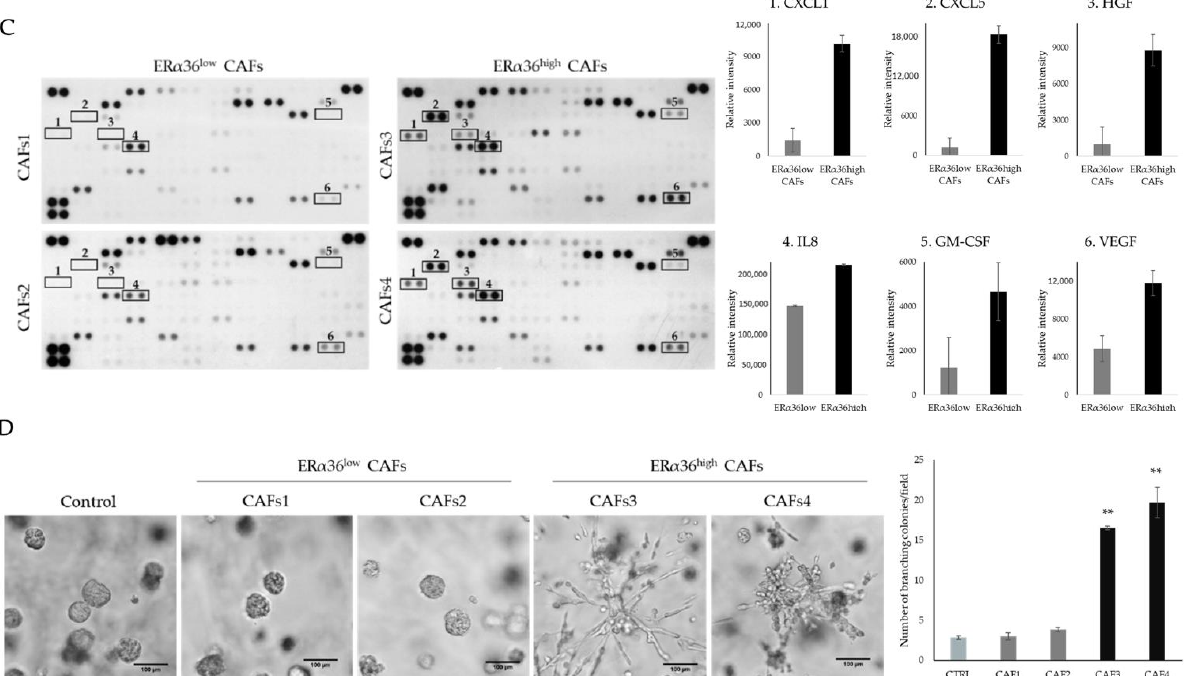
Figure 1. Characterization of CAF cultures from BC patients, ( A ). ER α 36 staining (green) by IF and nuclear DAPI staining (blue) of the obtained CAF cell cultures, scale bar: 50 µ m. ( B ). nCounter PanCancer Immune Profiling panel analysis of gene expression in ER α 36 hihg CAFs vs ER α 36 low CAFs, genes with logFC > 1 (FC—fold change) were considered upregulated, genes with logFC < − 1 were considered downregulated, ( C ). Human Cytokine XL Profiler analysis of conditioned media obtained from CAF cultures. The left panel shows secretomes of ER α 36 high and ER α 36 low CAFs with marked spots that were secreted differently between the two groups, the right panel quantifies the changes in the six selected cytokines levels, ( D ). 3D matrigel cultures of the TNBC MDA-MB-231 cells treated with the condition media from ER α 36 high or ER α 3 low CAFs. ER α 36 high CAF-conditioned media significantly induced branching in MDA-MB-231 cells, ** p < 0.0001 calculated vs control; colony photographs were taken using 10 × magnification.